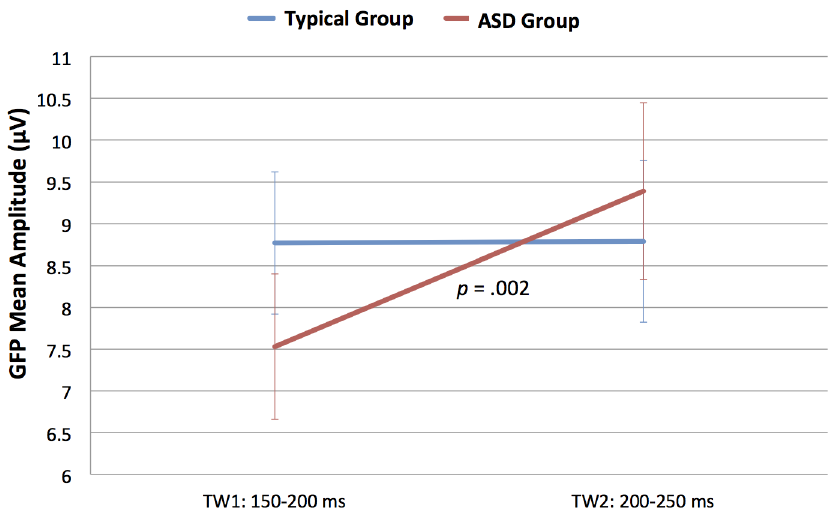
Fig 3. Time Window x Group interaction. Mean and standard error bars of the GFP to the picture (P1 peak) at the two time windows for the two groups.